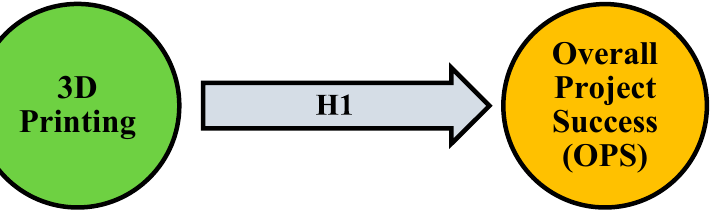
Figure 1. Hypothesised relation between 3D printing and OPS (time, cost, quality, public health and safety and environment).